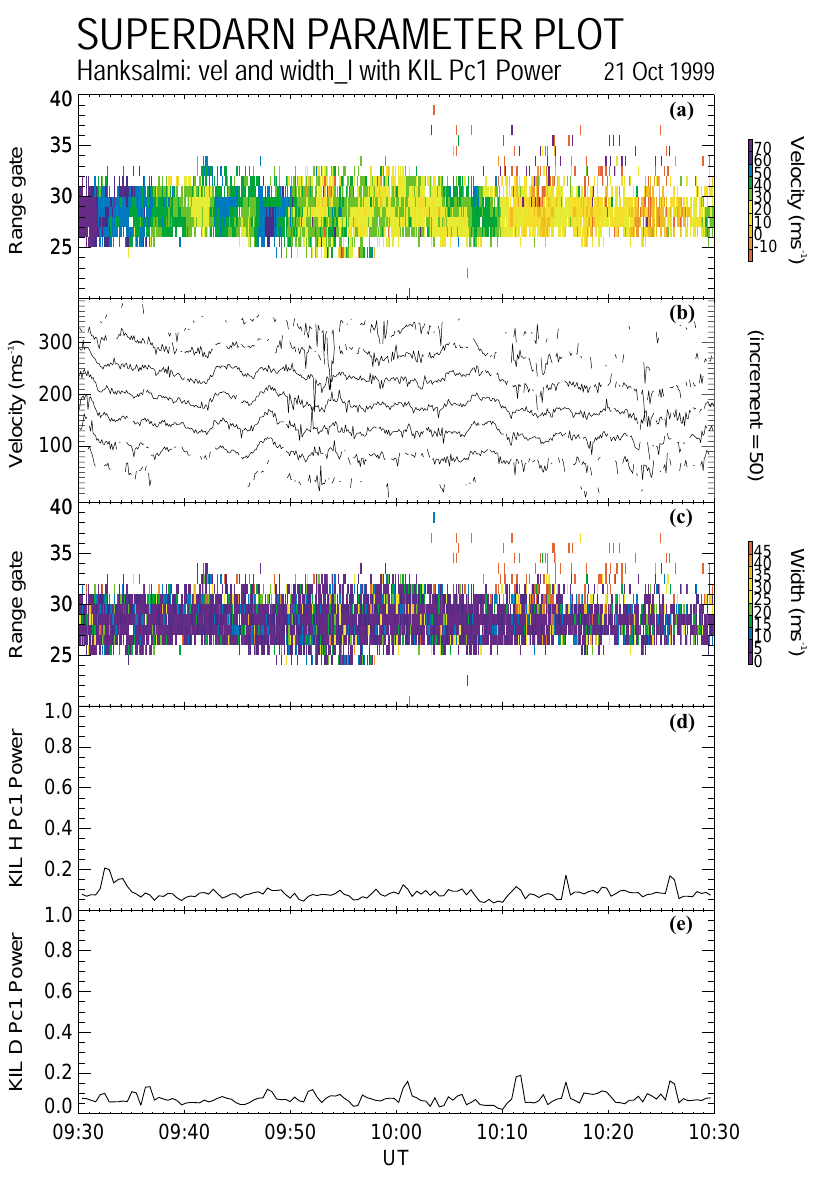
Fig. 8. Data in the same format as Fig. 7 from 09:30–10:30UT on 21 Oc- tober